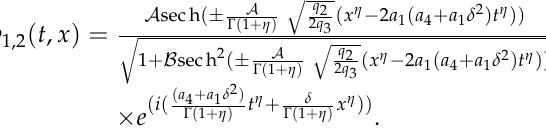
Figure 4. Trajectories of the dynamical system (17), where ( a ) a 1 = 1, a 2 = 0, a 4 = 0, q 1 = 1, q 2 = − 0.1, q 3 = − 1, γ = 1, δ = 1, β = 1; ( b ) a 1 = 1, a 2 = 0, a 4 = 0, q 1 = 1, q 2 = − 0.1, q 3 = 1, γ = 1, δ = 1, β =